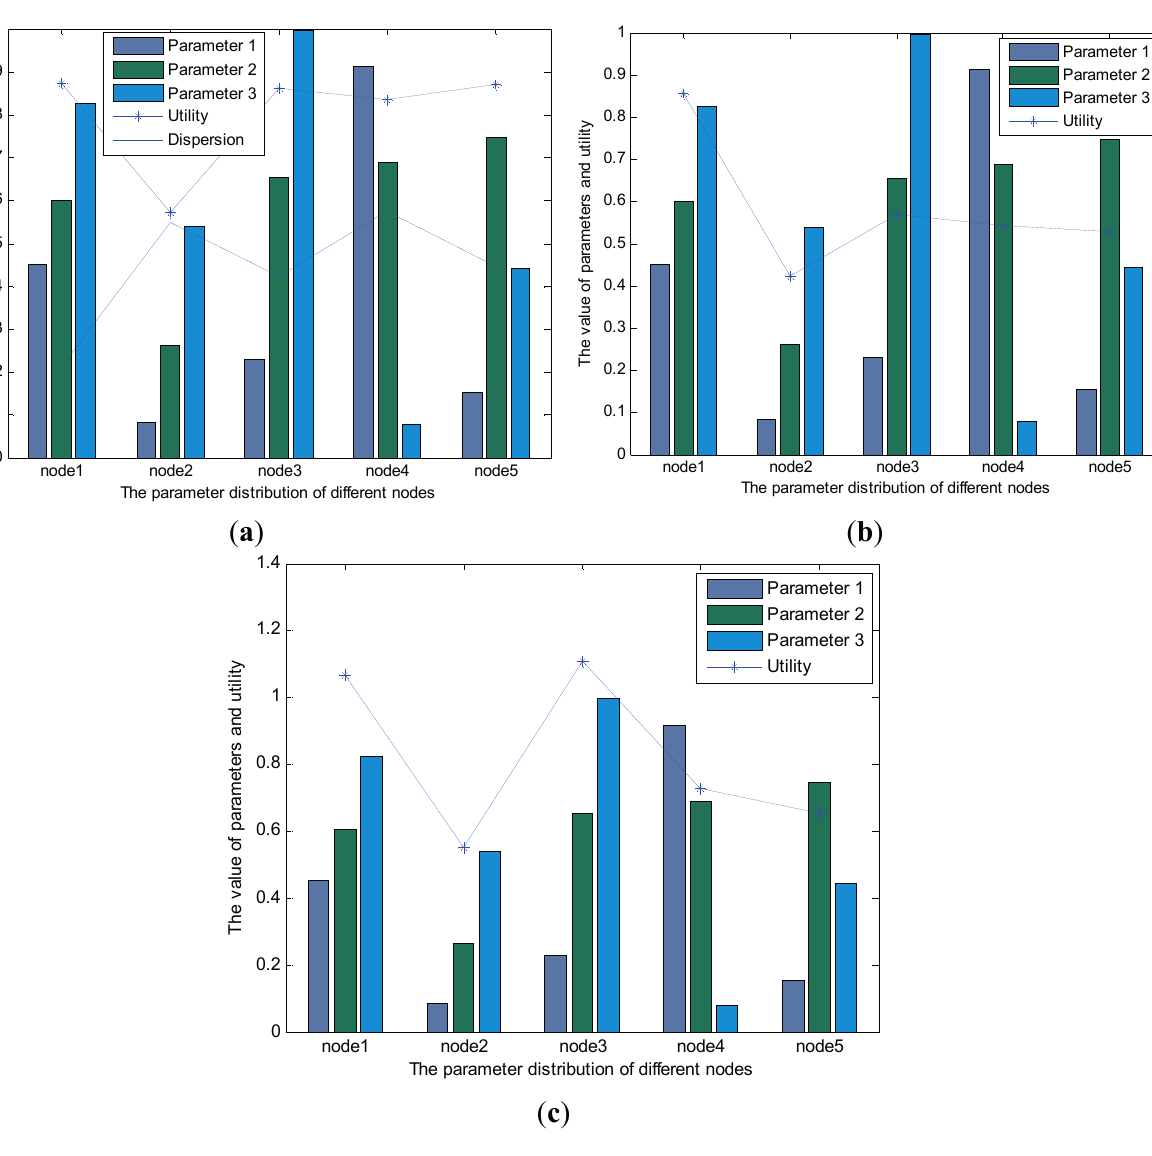
Figure 5. ( a ) The result of the BCFL; ( b ) The result of the traditional fuzzy logic-based routing algorithm (the algorithm used in [19,20]); ( c ) The result of the optimization-based routing algorithm (the algorithm used in